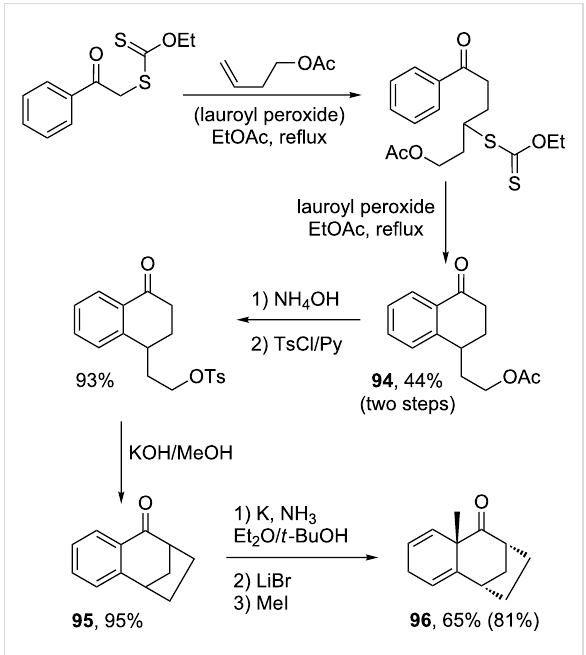
Scheme 19: A polycyclic structure via the alkylative Birch